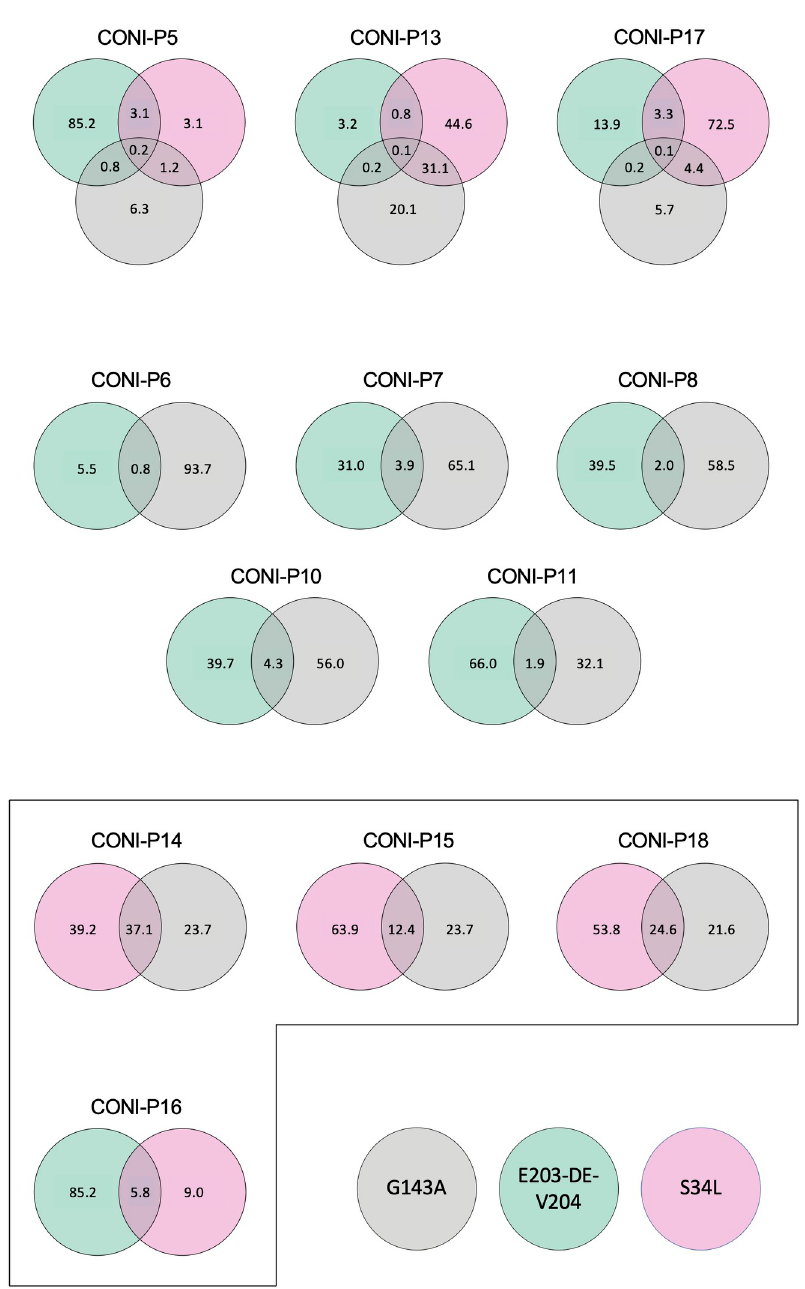
Fig 2. Cyt b sequences from field populations of P . viticola may show several changes correlated with resistance to cyazofamid and ametoctradin. For each population where at least two different variants were detected (Table 3), and considering only ONT reads with variants, the percentage of each type of variant (E203-DE-V204, S34L or G143A; Table 2) observed in the same read is indicated in the Venn diagram. Framed diagrams indicate populations where more than 5% of the reads have two different variants on the same